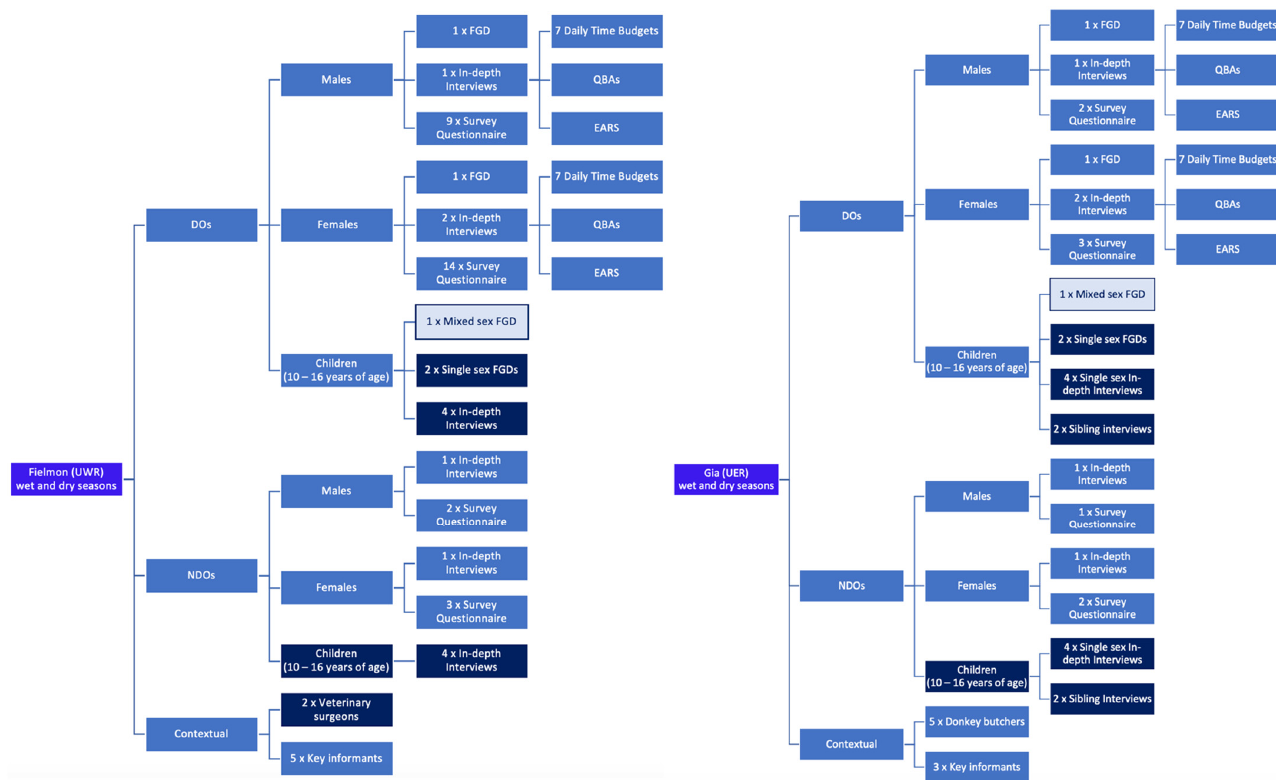
Figure 3. Study Research Instrument Schedule: the number of each research instrument conducted in each study site, with which audience. Table 1. Children’s Focus Group Participants.